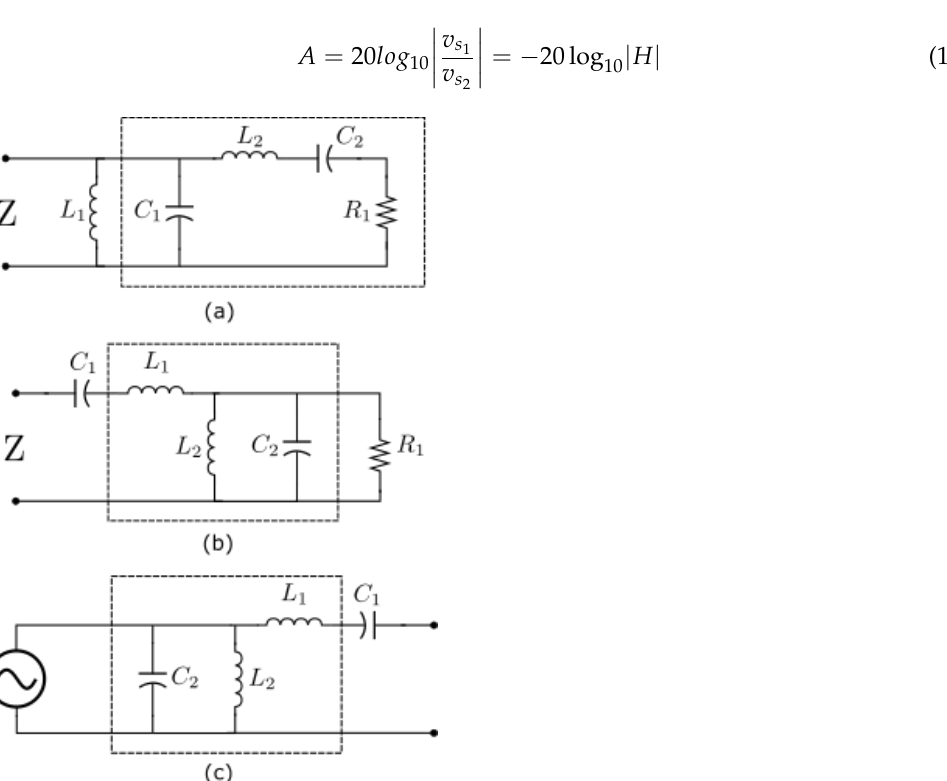
Figure 4. Coupling equipment. ( a ) Wave trap. ( b ) Receiving-end line tuner. ( c ) Transmitting-end line